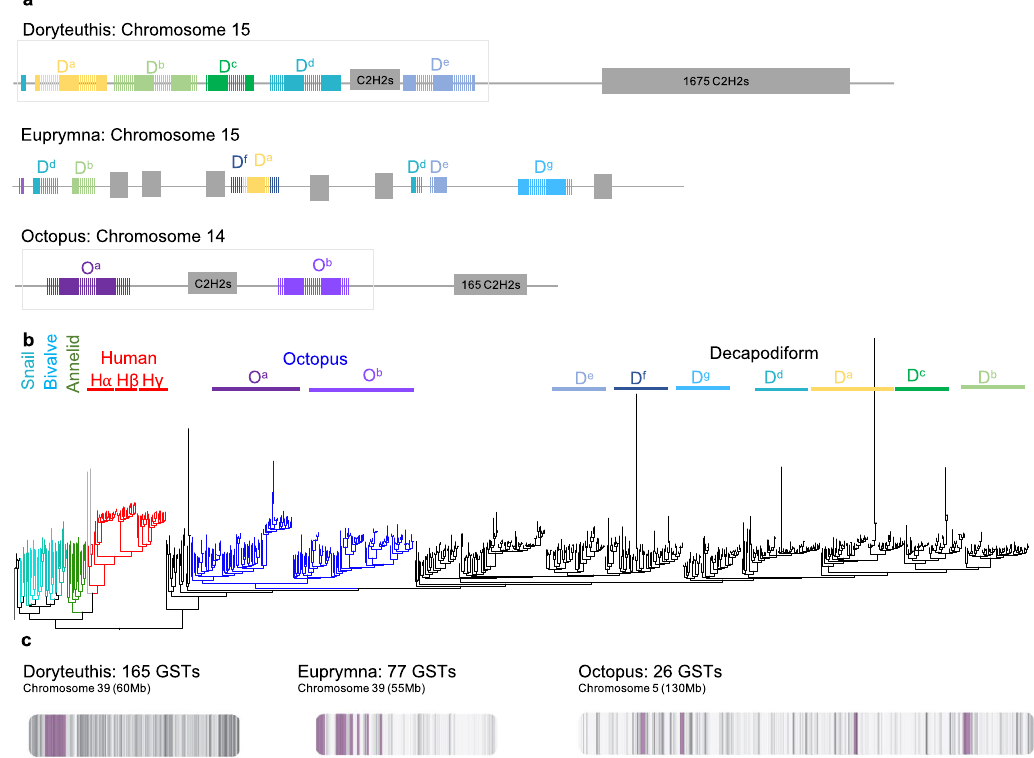
Fig. 5 Expansion of gene families. a Protocadherin gene clusters in cephalopod genomes. The protocadherin- and C2H2-rich chromosomes for D. pealeii, E. scolopes , and O. bimaculoides are shown to scale. 285/288 D. pealeii PCDH s are located within a 50 Mb cluster on chromosome 15 (box). Of these, 163 are found in 5 tight subclusters of 40 (D a , yellow), 37 (D b , grass green), 20 (D c , green), 36 (D d , teal), and 30 (D e , blue) genes. All but the D e are facing in the same transcriptional direction. E. scolopes also demonstrates multiple clusters of PCDH s spanning chromosome 15. The orthologous chromosome in O. bimaculoides contains 149 of 168 PCDH s found in the genome, with two notable subclusters of 34 and 27 genes. Major clusters of C2H2 genes are noted in gray. b Phylogeny of coleoid (octopus: blue, decapodiform in black), snail ( Lottia gigantea , teal), bivalve ( Crassostrea gigas , sky blue), annelid ( Capitella teleta , green) and human (red) PCDH s demonstrates lineage-speci fi c expansions. A handful of very long branches in the decapodiform protocadherins correspond to truncated sequences that may represent pseudogenes. Notably, genomic clusters (indicated above the phylogeny by different color bars) also cluster on the tree. c Arrangement of S-crystallins/Glutathione S-transferases (GSTs) in cephalopod genomes. Purple bars indicate the location of GST genes, gray gradient indicates gene density. D. pealeii has 139 GST s in a single cluster spanning 60 Mb on chromosome 39. The orthologous chromosome in E. scolopes contains 77 GST s distributed in multiple clusters, while in octopus, 26 GST s are found spanning chromosome